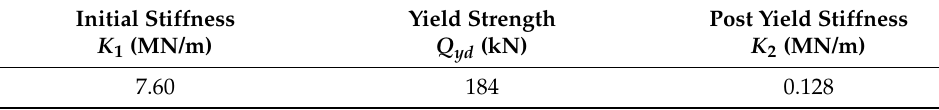
Table 4. Properties of the selected steel